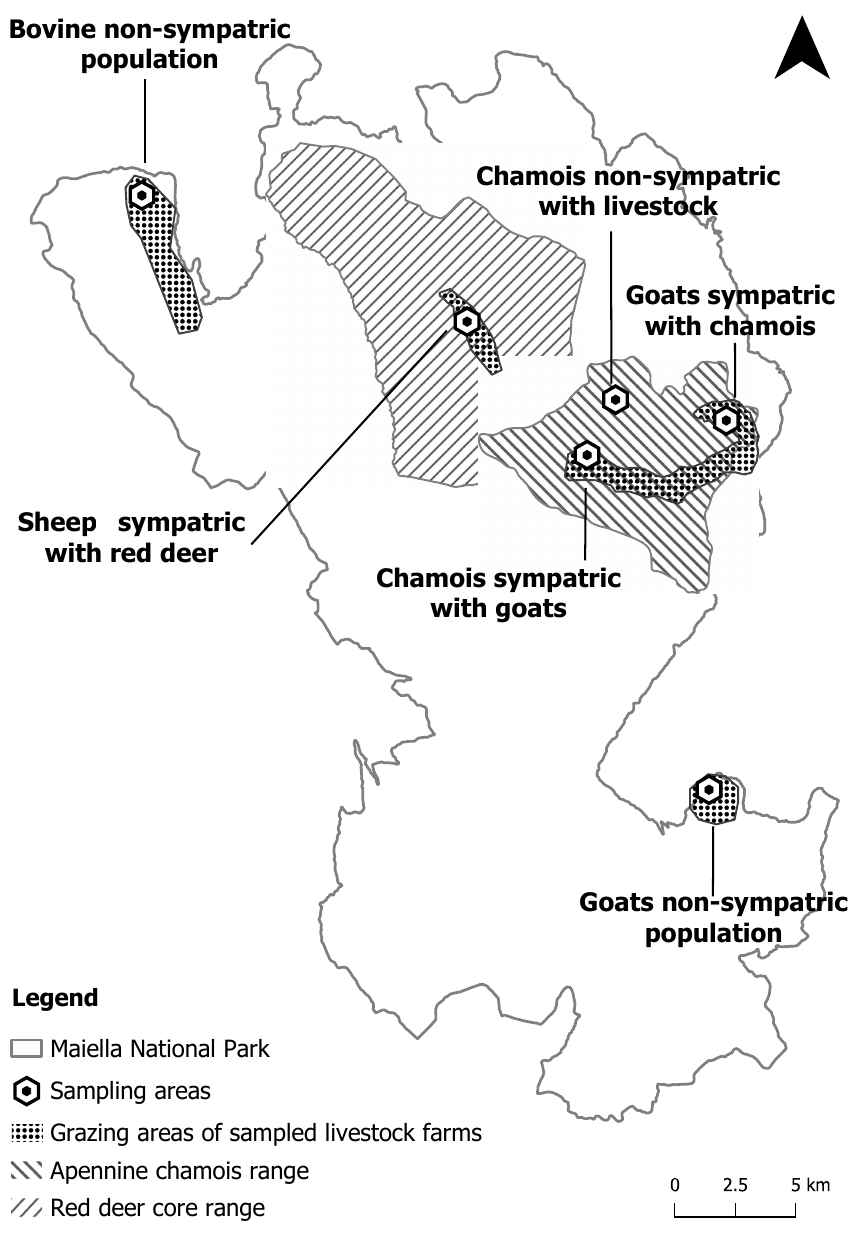
Figure 1. Maiella National Park boundaries, geographic distribution of sympatric and non-sympatric animals, and sampling areas.